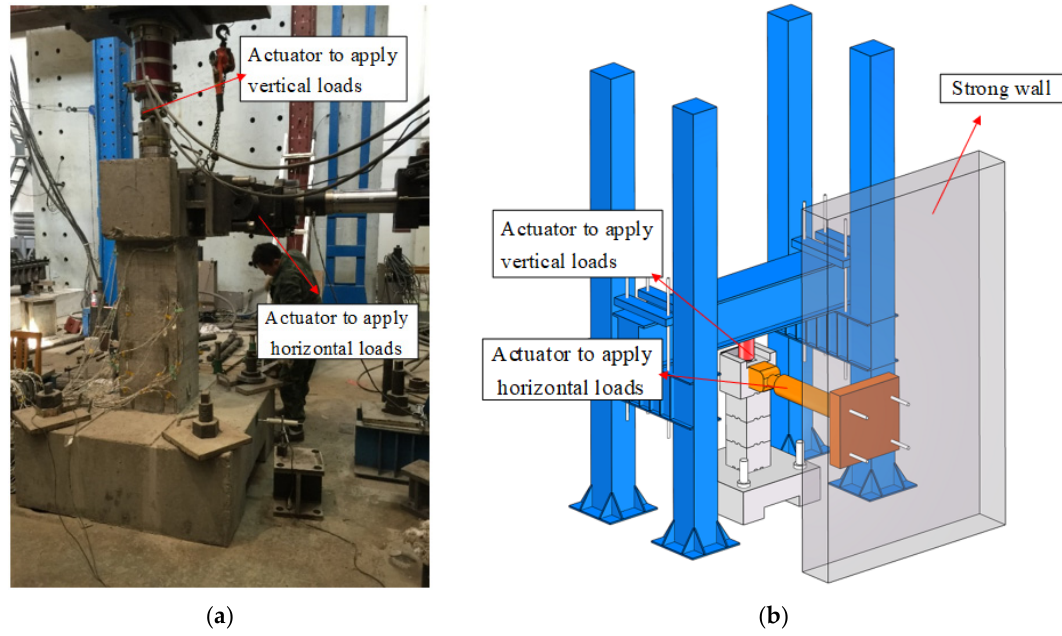
Figure 4. Test setup. ( a ) Photo. ( b ) 3D view Before the official start of the test, the vertical load is prepressed, and then the vertical load is increased to 300 kN and kept constant. After completing the vertical load applica- tion, the horizontal loading equipment was controlled to carry out step-by-step loading. Through theoretical calculation, the displacement of the prefabricated hollow pier speci- mens’ stage is 6 mm when the peak bearing capacity is reached. Therefore, horizontal load was applied by displacement control, and the initial loading level is 1 mm. When it reached 6 mm, the loading level was adjusted upward by 2 mm increments. When it reached 12 mm, the loading level was adjusted upward by 4 mm. When it reached 28 mm, the loading level was adjusted upward by 6 mm. When it reached 40 mm, the loading level was adjusted upward by 10 mm. When it reached 50 mm, the loading level was ad- justed upward by 20 mm. When it reached 70 mm, the loading test ended. 2.4. Instrumentation The strain gauges were attached to the concrete surface of each section near the glue joint, and the patching scheme was symmetrical on both sides (forward and backward), with a total of 24 measurement points, as shown in Figure 5a. The steel strain gauges were pre-buried before specimen casting, with a total of 20 measurement points. The specific measurement point locations are shown in Figure 5b.